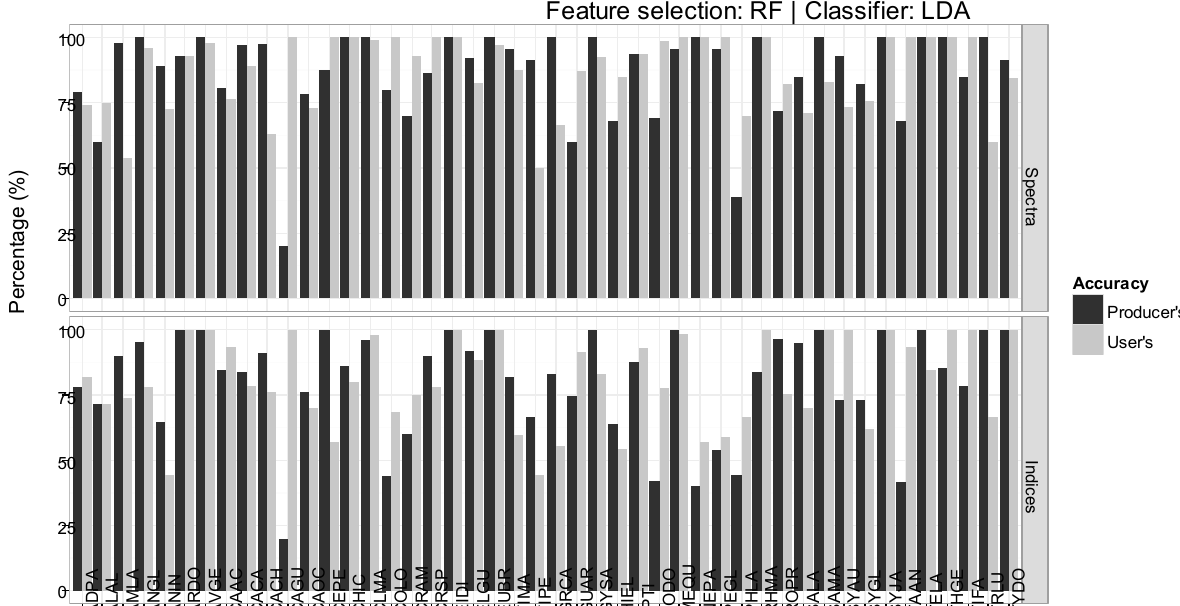
selection method and the LDA classifier for spectra and spectra-derived